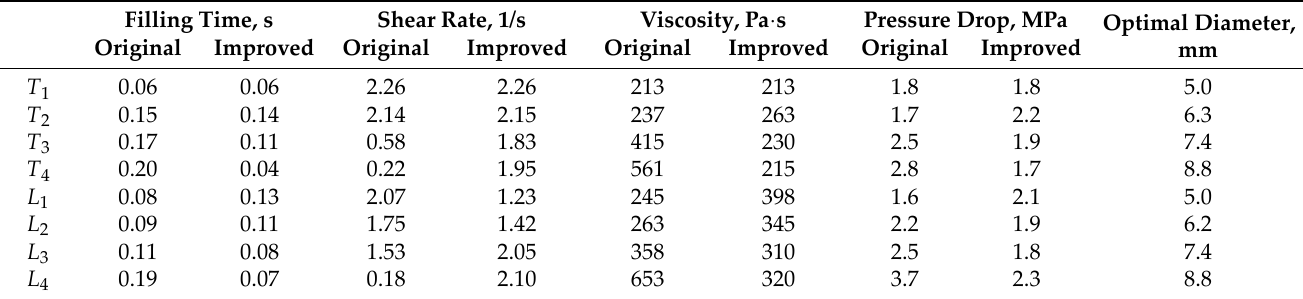
Figure 3. A half layout of the fishbone runner of a16-cavity mold. Table 1. Rheological properties at each runner and the optimal diameters.